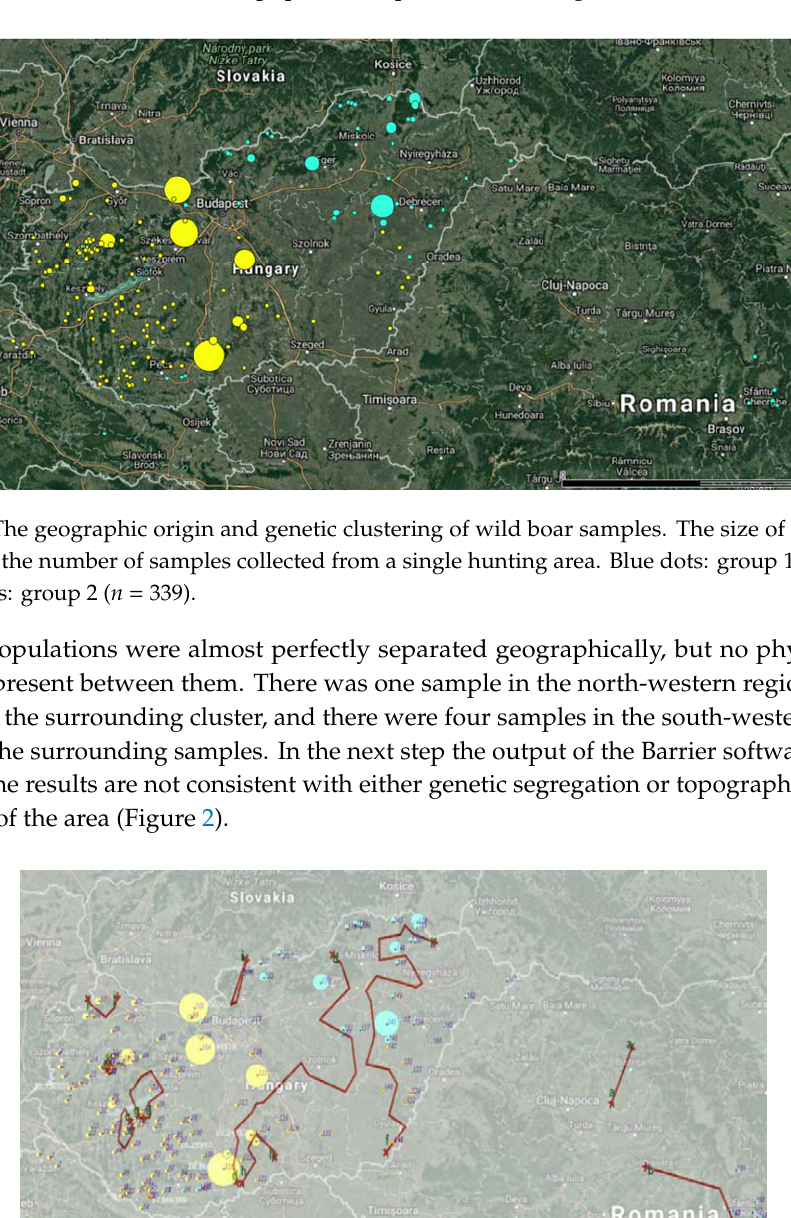
Figure 3. The results of the genetic analysis (Geneland) compared with the geographic analysis (Barrier), represented on the hydrographic map of the Carpathian Basin in the mid ‐ 1800 ′ s. Red lines indicates the possible barriers to gene flow. No clear correlation can be detected in this case either; however, the location of the smaller subpopulation is roughly the same as the floodplain in the north ‐ eastern part of the country bordered by the Mátra mountains. 3.3. Genetic Indices of Subpopulations Per population diversity values were similarly high as that for the whole sample set (Table 2).